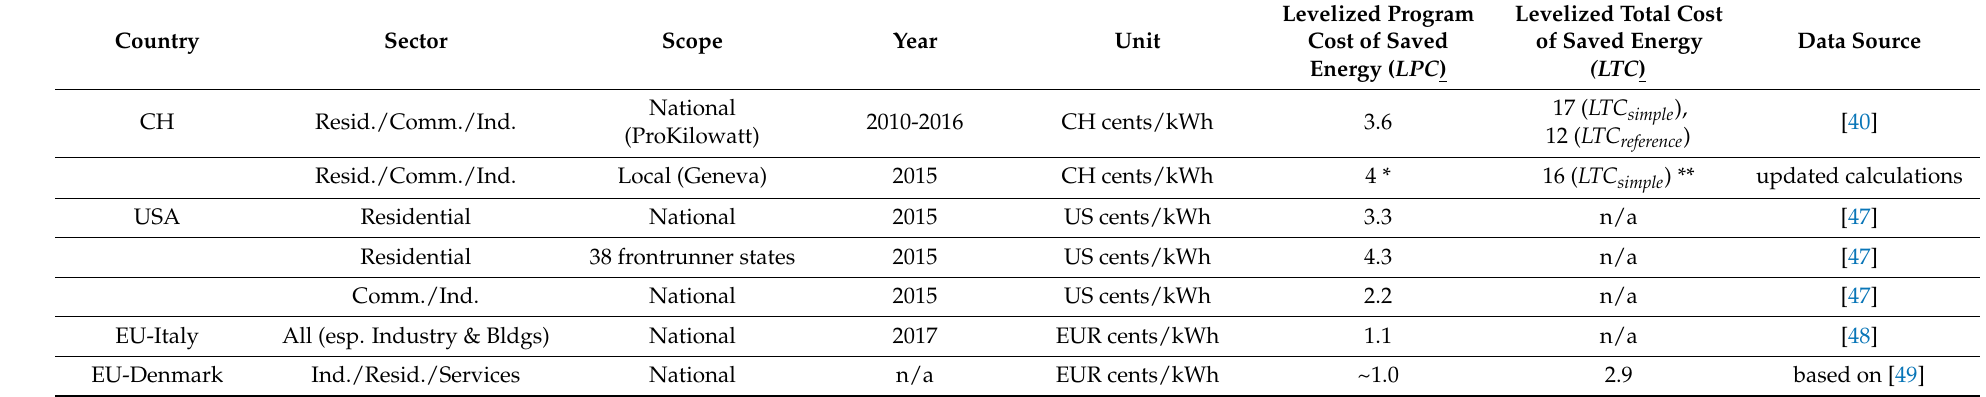
Table 2. A summary of the cost-effectiveness data from programmes in U.S.A., the EU and Switzerland (values for Switzerland concern electricity saving programmes only, while fuel savings are included in the values reported for the other countries).